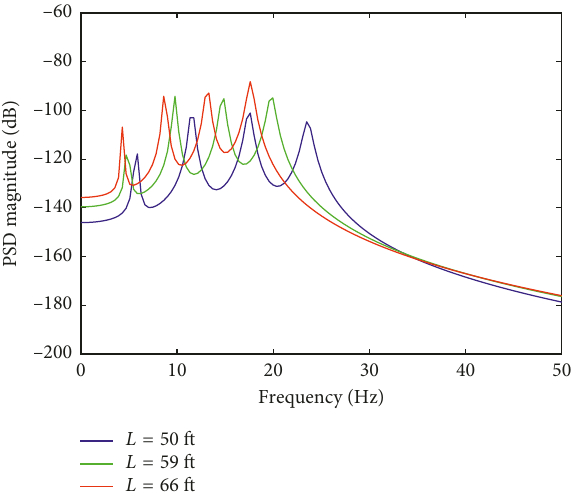
Figure 3: Analytic PSD function length comparison.